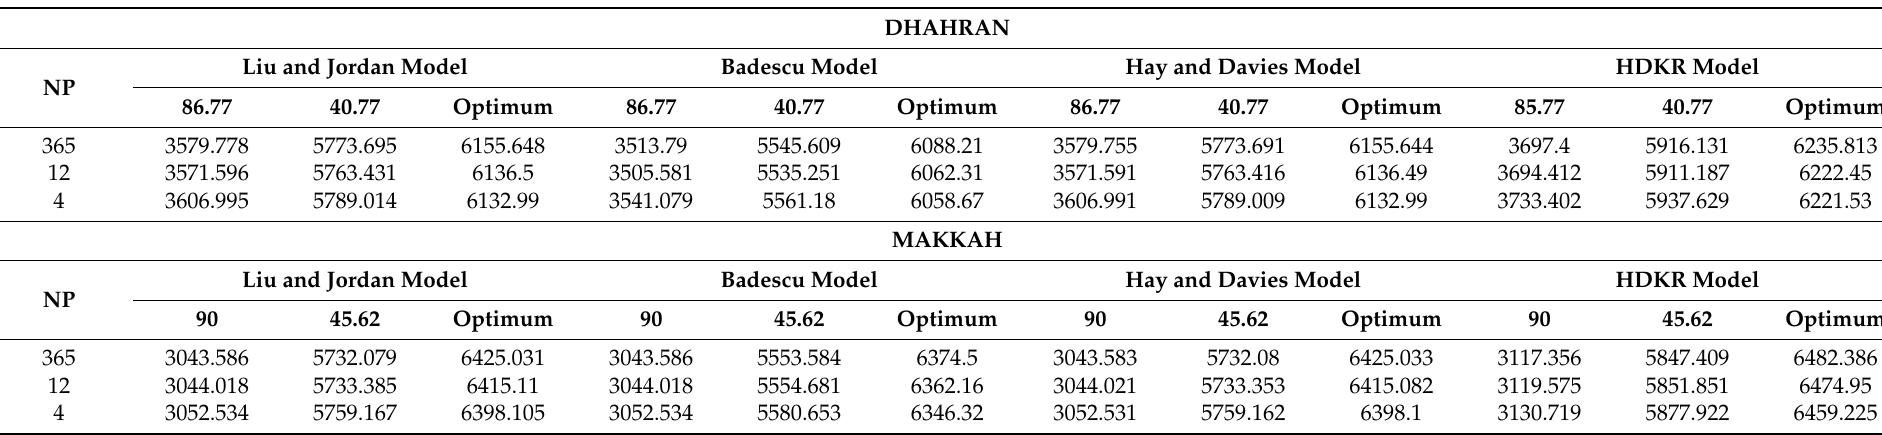
Table 12. Total radiation on a tilted surface for various yearly tilt angle modifications vs. the optimum tilt